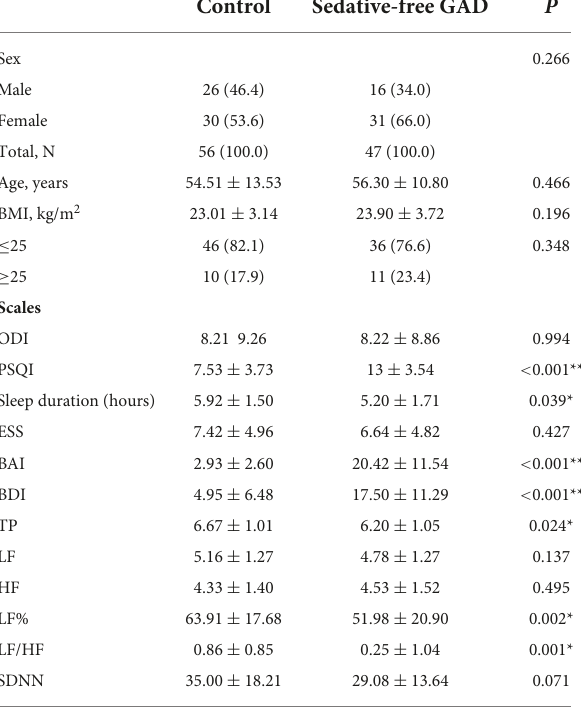
TABLE 1 Comparison of demographic data and clinical characteristics of the study participants.